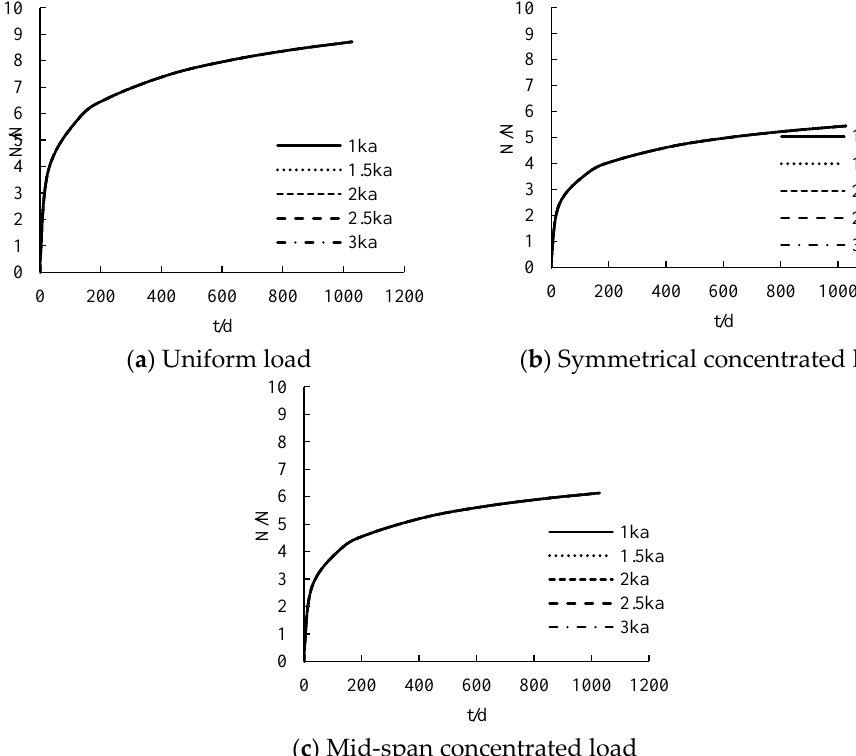
Figure 12. The influence of adhesive layer stiffness under creep on tensile force.